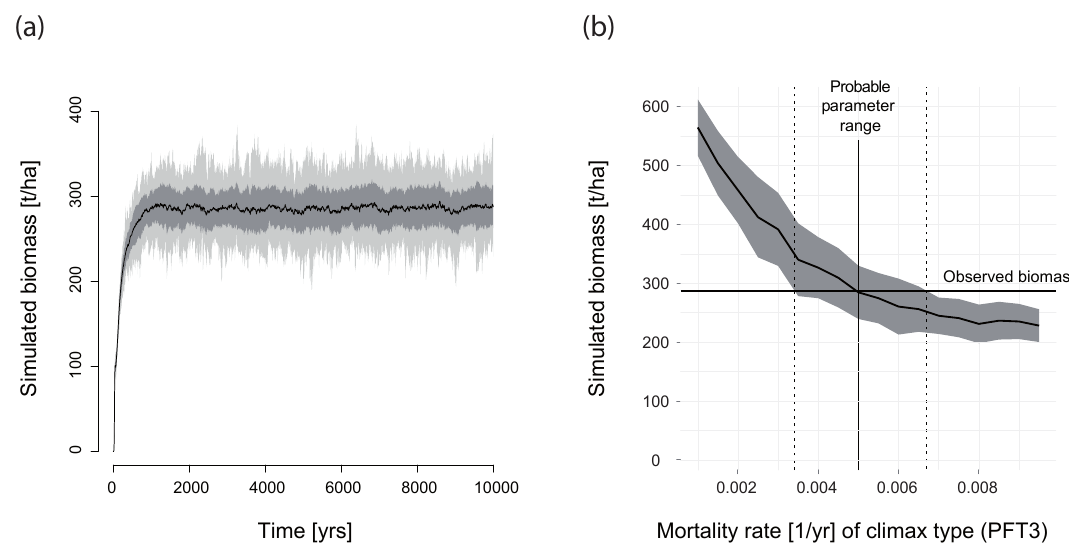
Fig. 1. Principle of statistical inference through stochastic simulation. (a) shows mean model predictions (black), standard deviation (gray) and min/max values (light gray) for the biomass of a 1ha plot over 10000yr, starting from an empty plot. (b) shows the same mean equilibrium biomass (black) and two standard deviations (gray), but as a function of the mortality of the late-successional type PFT 3; all other parameters constant. Comparing the observed biomass from (a) , which was created with a mortality rate of 0.005, with the predicted biomass for different mortality rates, we can infer the original value as well as a statistical uncertainty, without having to define a statistical